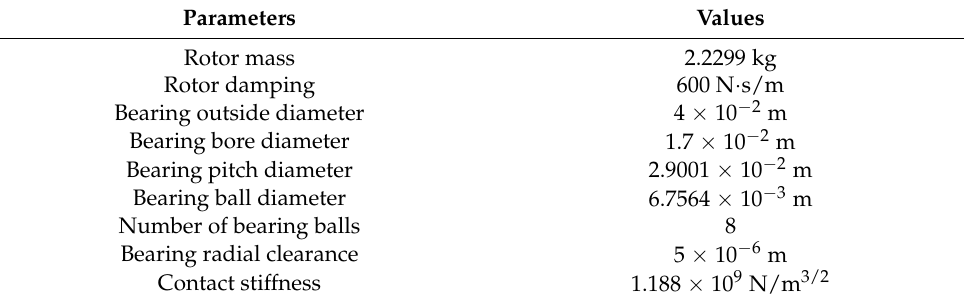
Table 3. Parameters of the rotor-bearing dynamic